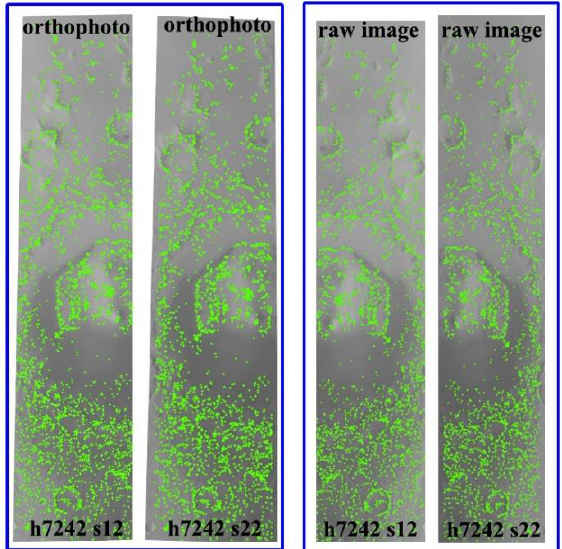
Figure 3. Tie points extraction on orthophotos and converted to the raw images. Green spots indicate conjugate points.